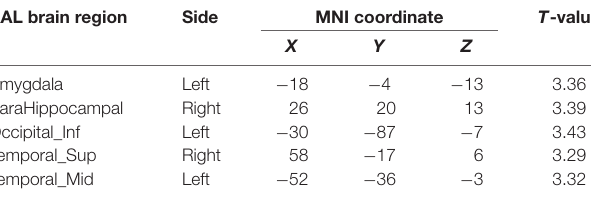
TABLE 4 | Differences in regions in terms of Tau distribution in the APOE 4+T −